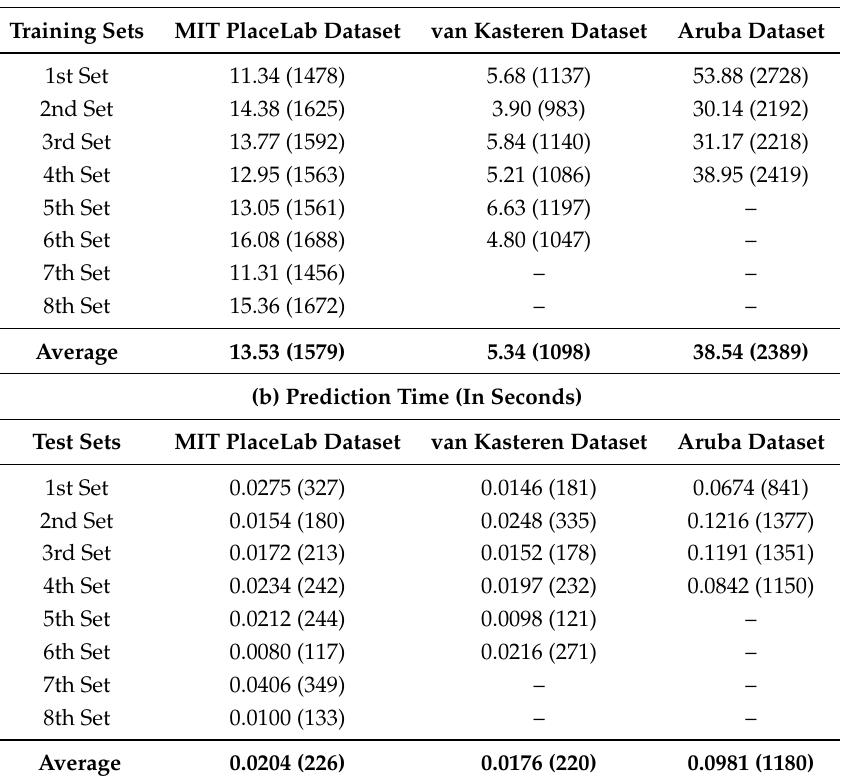
Table 7. Computational time: (a) Training time (in minutes) and (b) Prediction time (in seconds). The value in parentheses represents the number of user-interaction instances in each respective training/test